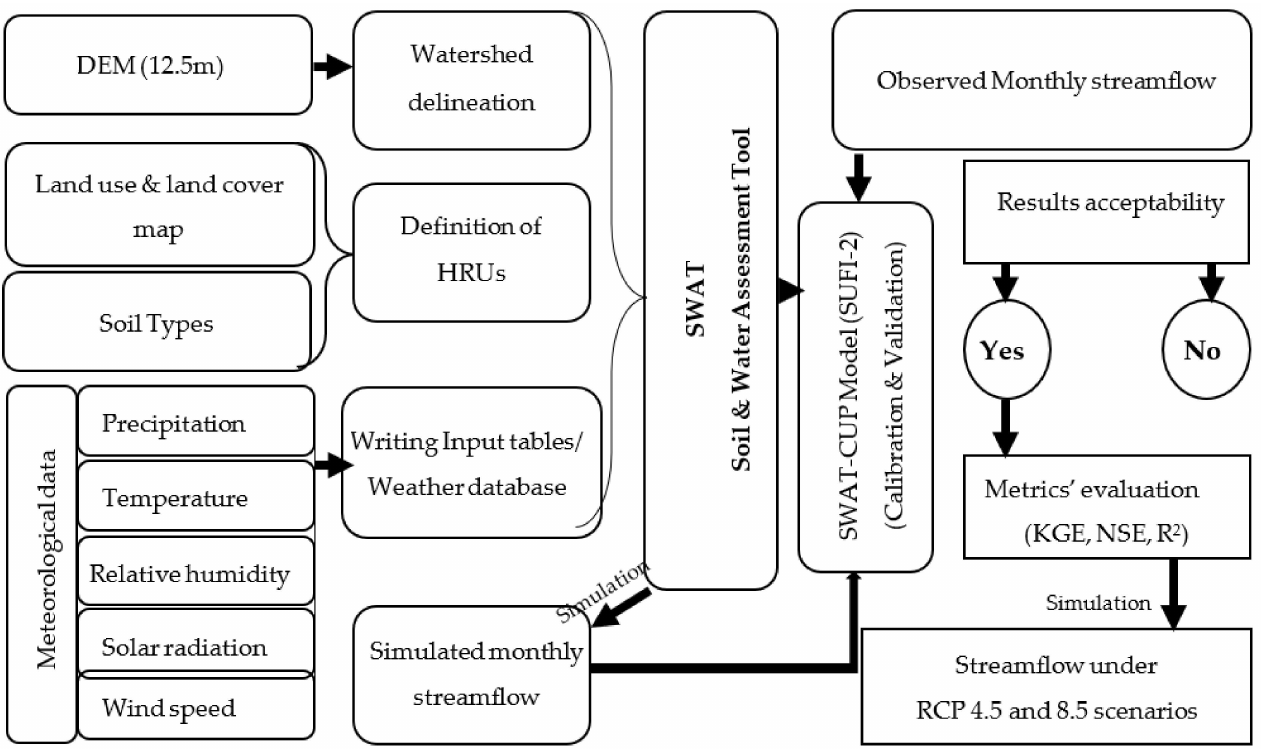
Figure 2. Methodological framework used for the evaluation of the performance metrics and simulat- ing streamflow under changing climate in the study region.